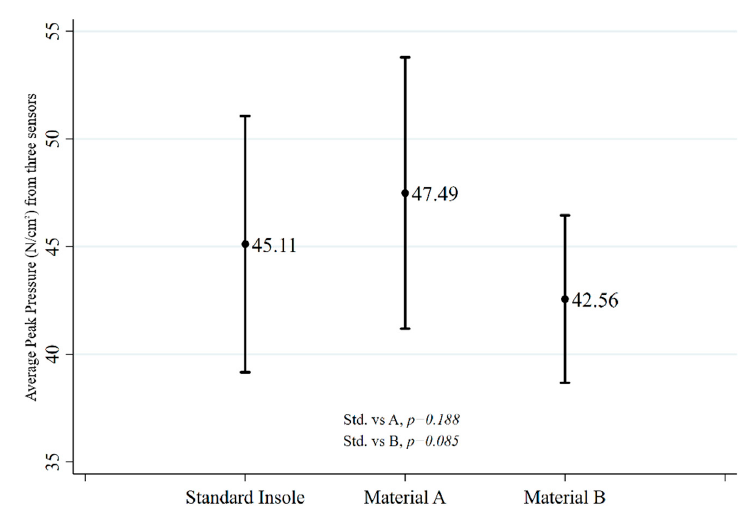
Figure 5. Average peak pressure for different insoles during the walk trials.